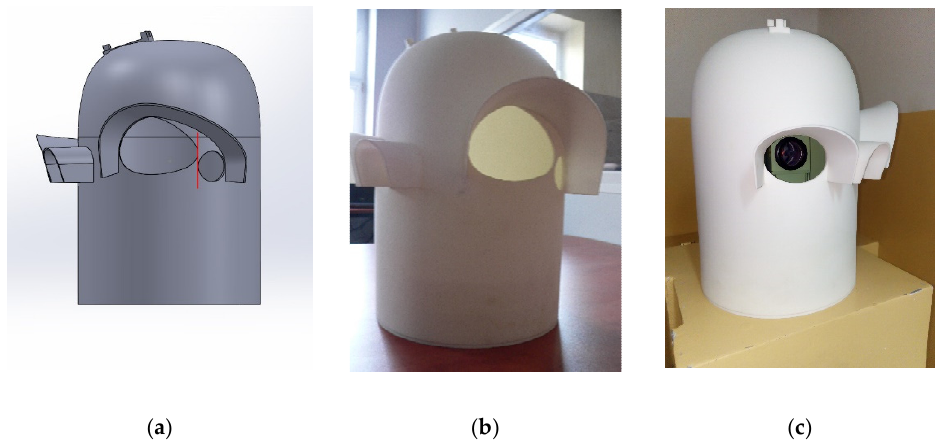
Figure 3. Schematic view of the protective housing development; ( a ) a digital model of the body; ( b ) a printed prototype; ( c ) a protected surveying instrument installed on a concrete pillar in a laboratory.